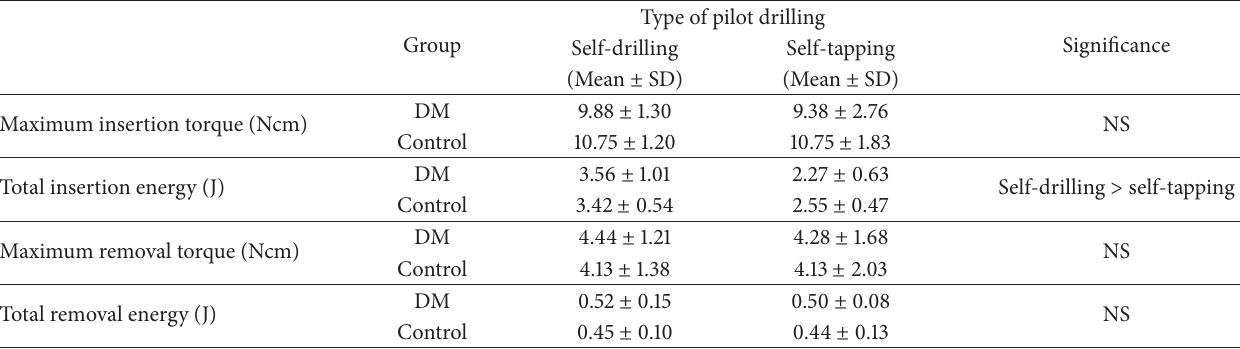
Table 2: Maximum torque (Ncm) and total energy (J) during insertion and